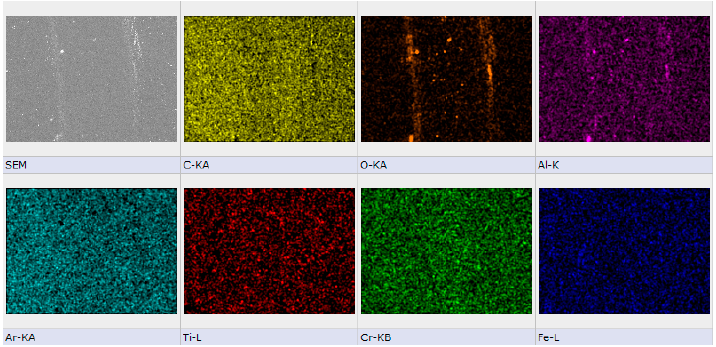
Figure 9. SEM-EDS images of the wear track on the coating obtained in Ar/C 2 H 2 gas mixture after the tribological test with sapphire ball as counterpart. F = 10N, sliding distance 400 m.